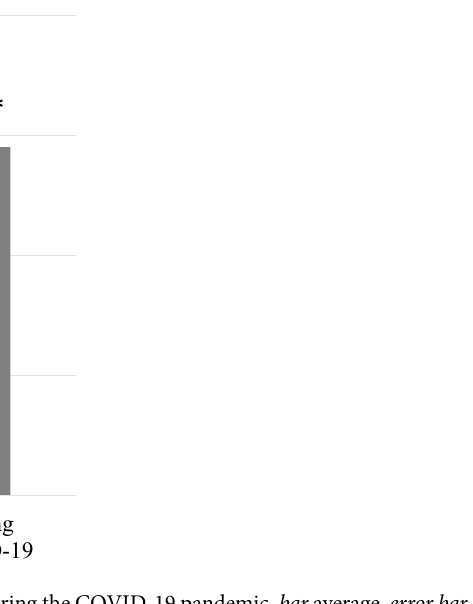
Figure 1. WHO-5 score before and during the COVID-19 pandemic. bar average, error bar standard error. ***: p < .001.